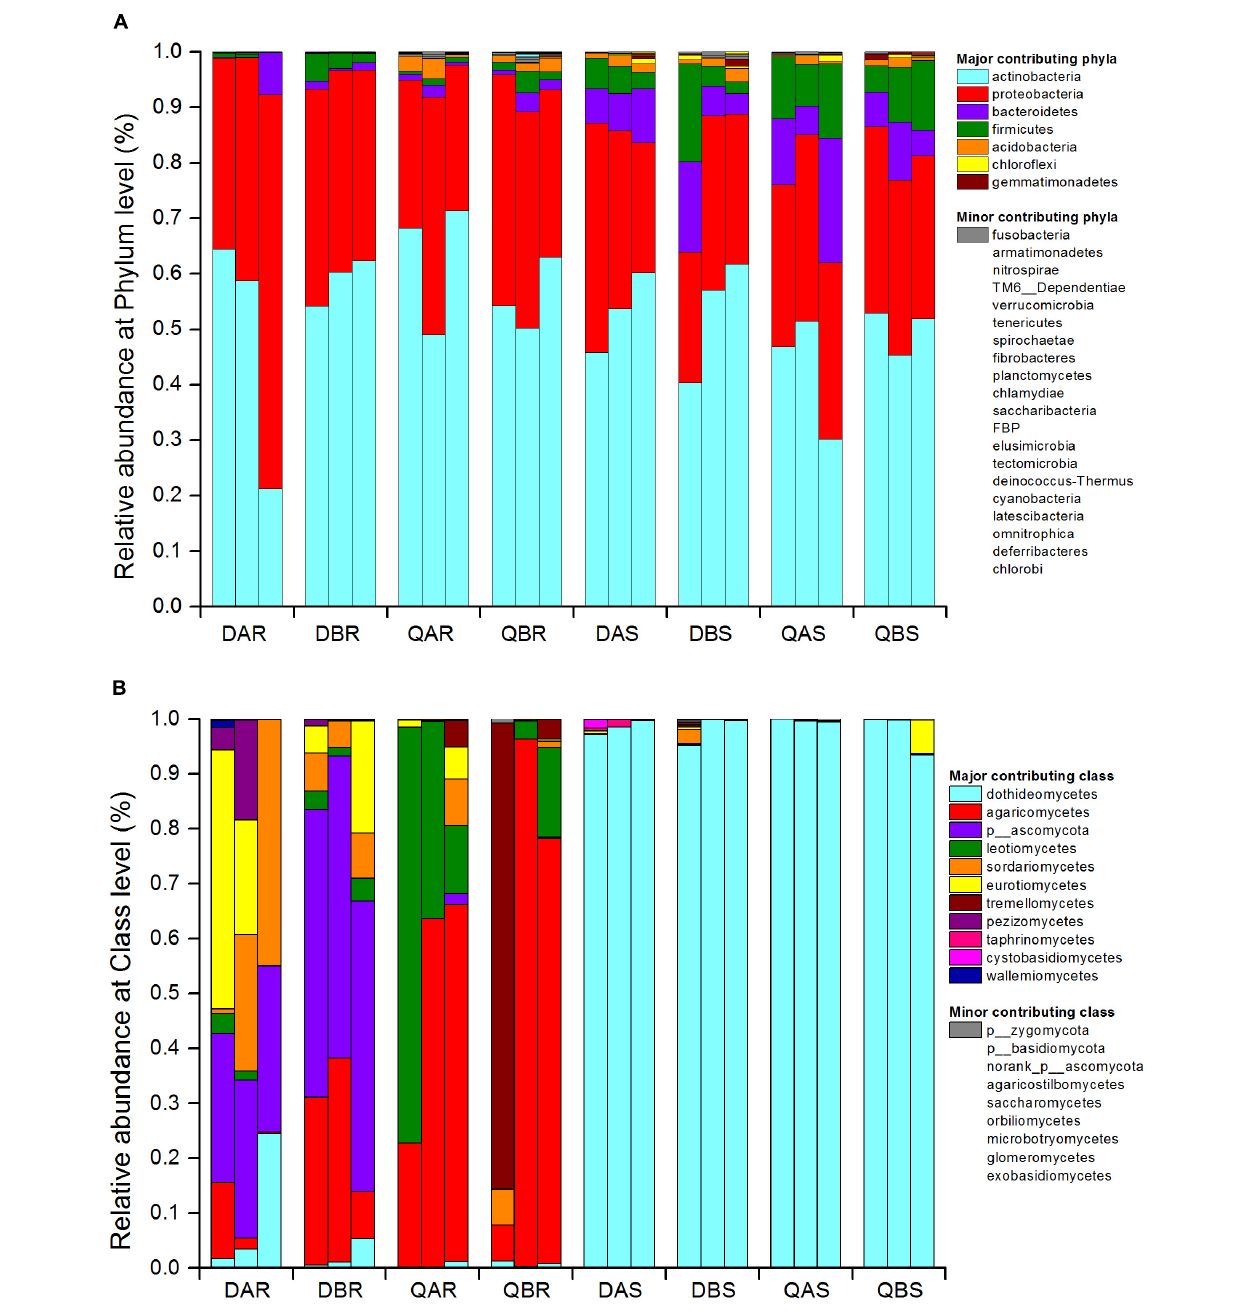
FIGURE 5 | Bacterial community structure at the phylum level (A) and fungal community structure at the class level (B) . Relative sequence abundance of bacterial phyla associated with the root and stem endosphere. The three biological replicates are displayed in separate stacked bars. Major contributing phyla are displayed in different colors and minor contributing phyla are grouped and displayed in gray. The fungal class are represented in the same way. Total relative abundances of all phyla of bacteria and class of fungi and significant effects are listed in Supplementary Tables S2, S5 ,